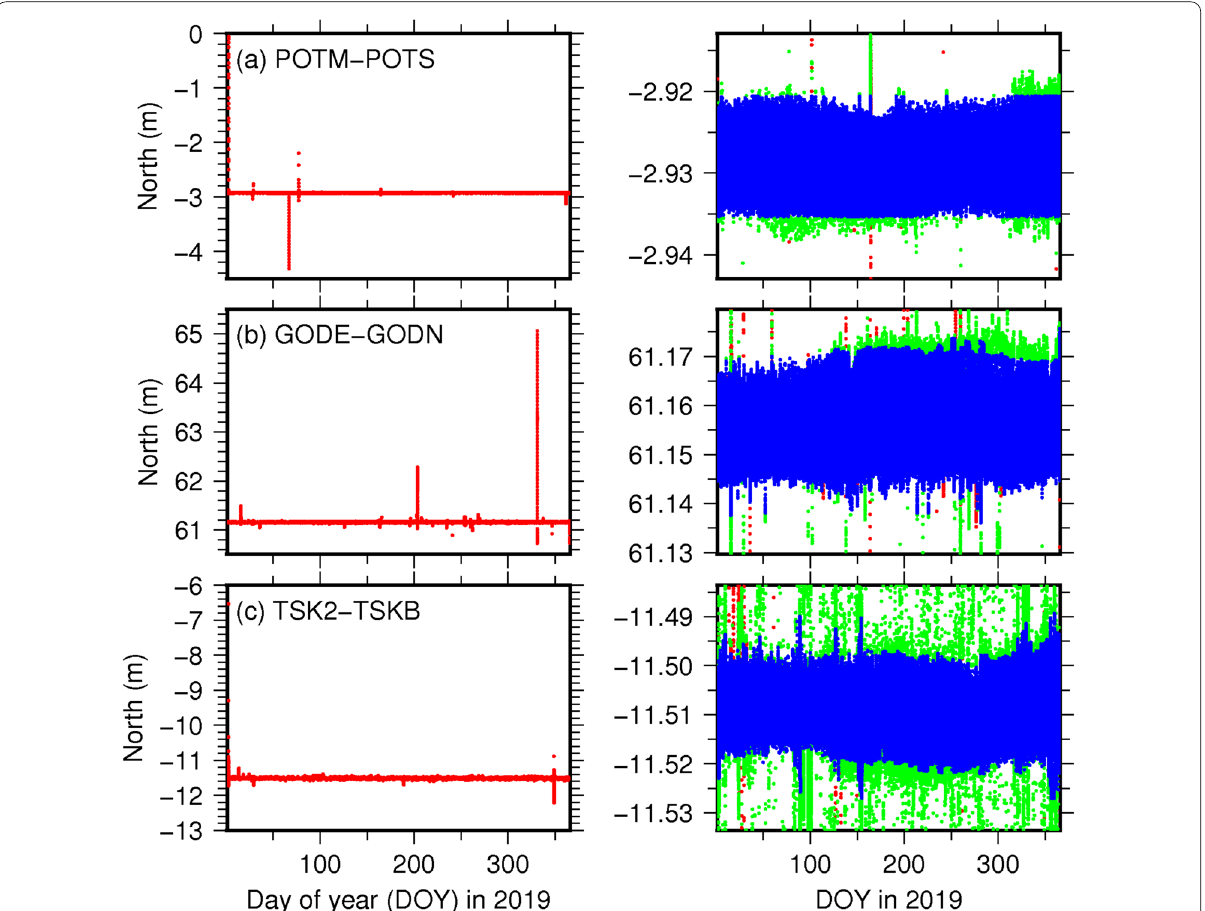
Fig. 1 Outlier removal process for the north component of three baselines as labeled. Right panels show closer look of fluctuation of baselines shown at left of each panel. Red dots indicate outputs of kinematic analysis of TRACK. Green dots indicate coordinates after removing epochs with large post-fit residuals of double difference (DD) and/or determined from small number of DDs (Additional file 1: Fig. S2; see section "Postprocessing to remove outliers"). Blue dots indicate coordinates with 30-s intervals after the interpolation of neighboring epochs for outliers removed from the green dots with the whole-year and the local standard deviation criteria (see section "Postprocessing to remove outliers"). The same plots but for the east and up components are provided in Additional file 1: Fig.